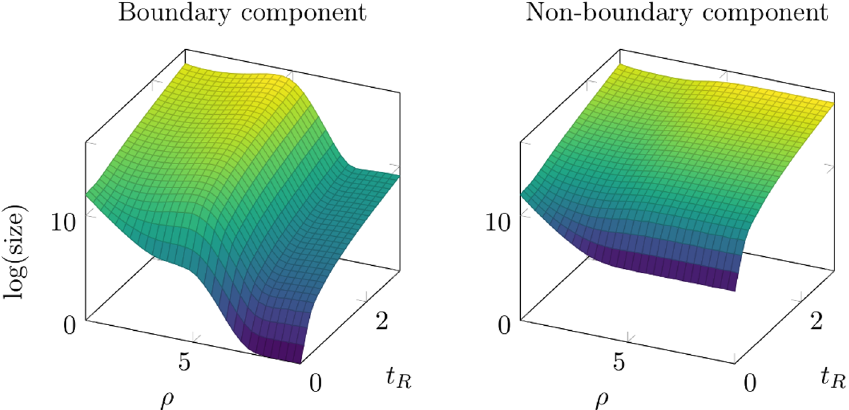
Figure 10. Size for large (cid:26) for q = 1000, (cid:12) size of the (cid:13) 1 = +1 component occurs at a (cid:12)xed (cid:26) for all t R , well after the (cid:13) 1 = saturated. Note there is a (cid:12)nite range of (cid:26) where it would appear both components are saturating to the same